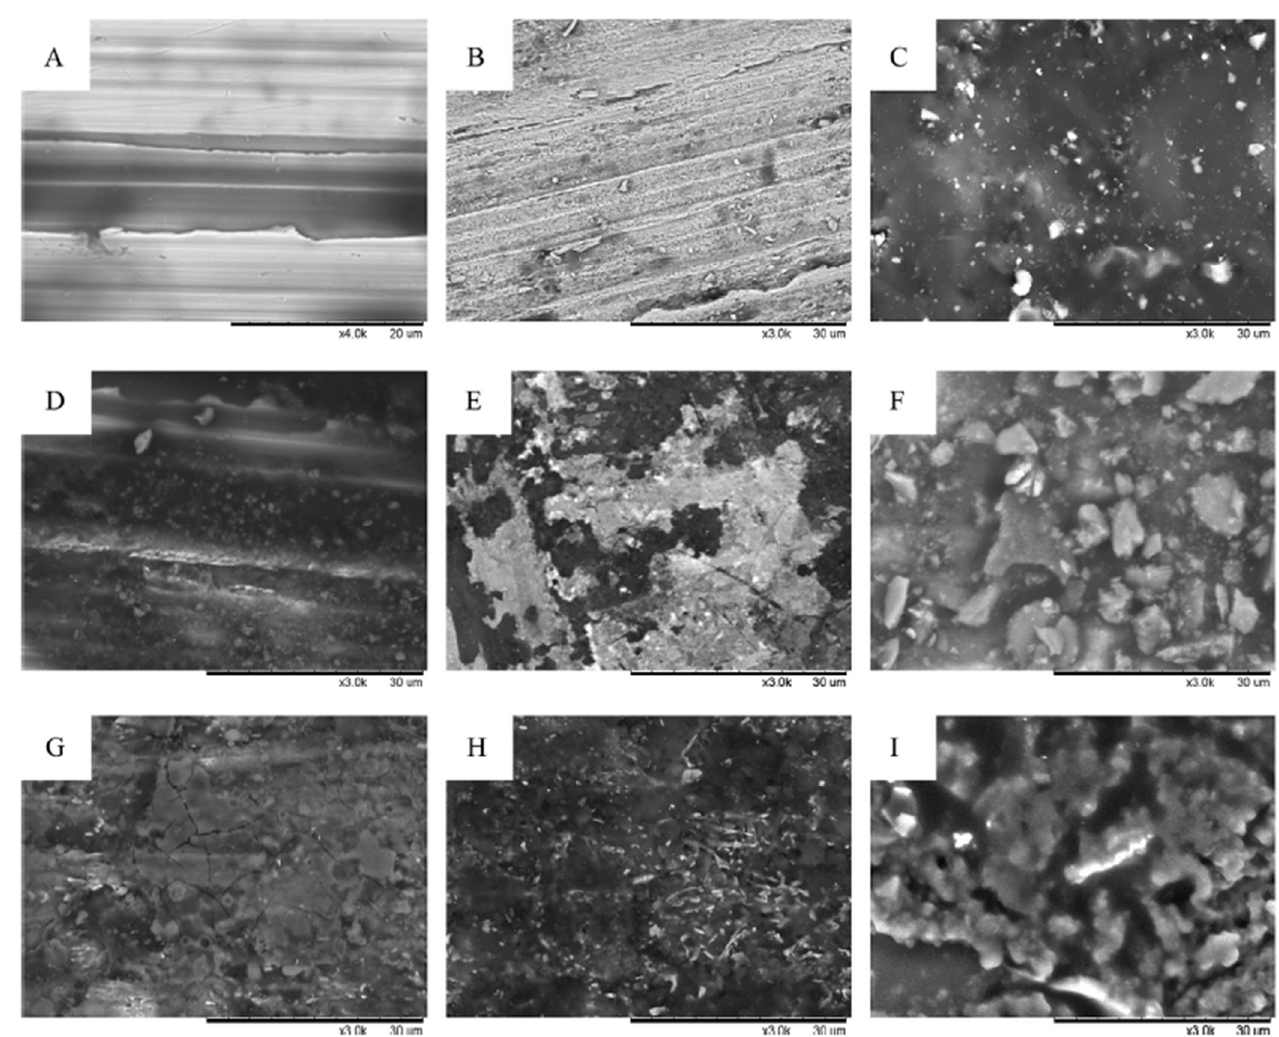
Figure 10. Surface morphology of ASTM 1045 MS in palm biodiesel at different temperatures 27, 50 and 80 °C for different exposure periods: ( A ) 27 °C —30 d; ( B ) 50 °C —30 d; ( C ) 80 °C —30 d; ( D ) 27 °C —60 d; ( E ) 50 °C —60 d; ( F ) 80 °C —60 d; ( G ) 27 °C —120 d; ( H ) 50 °C —120 d; ( I ) 80 °C —120 d [66].